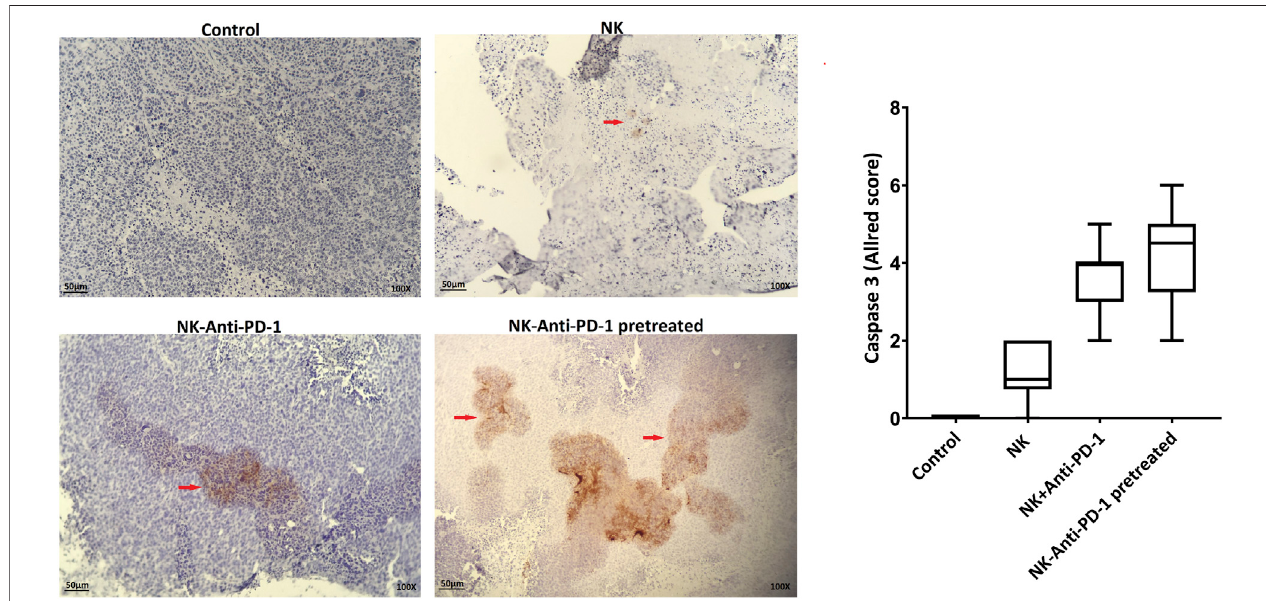
FIGURE 6 | Apoptosis induction by anti-PD-1 blockade NK cells. (A) Active caspase-3 was evaluated in the tumor section (red arrow, immunoreactive cells) and boxplots illustrate semi-quantitative analysis based on Allred score. Scale bar: 50 µm, 100X magni fi cation.